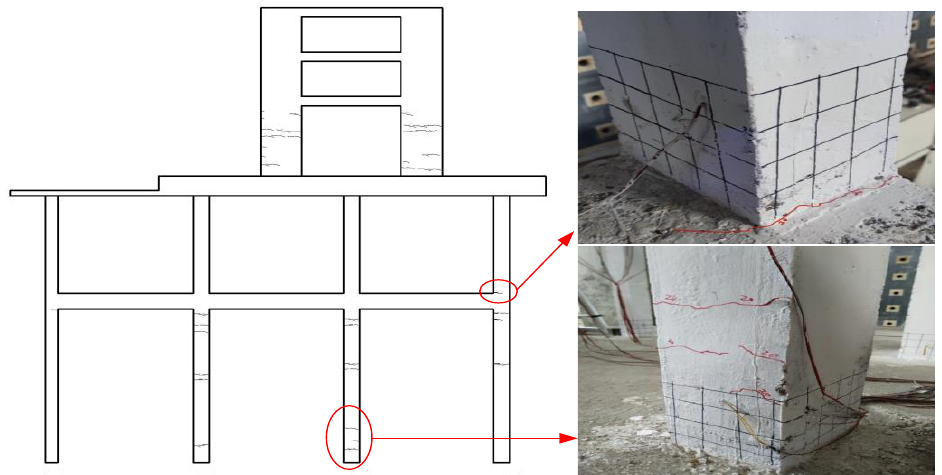
Figure 14. 8I-DBE damage condition. 7I-MCE damage condition: The column cracks of the first floor continued to increase, the beam and column nodes of the first floor showed new cracks, the slab surface cracks of the first floor also continued to develop. Horizontal cracks were found at the top of the frame columns on the second floor, but no cracks were observed in the transfer slabs. Cracks increased in the shear walls on the third floor, as shown in Figure 15.